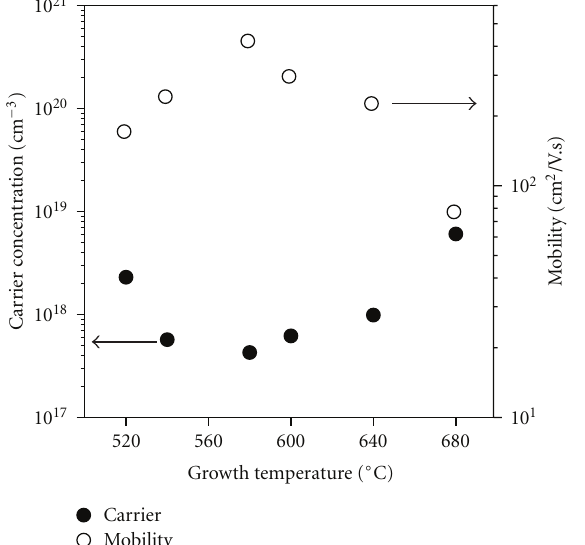
Figure 3: Dependence mobility and carrier concentration at 300 K on the growth temperature for Al 0 . 1 Ga 0 . 9 Sb layers grown on GaAs substrates with a V/III ratio of 3.